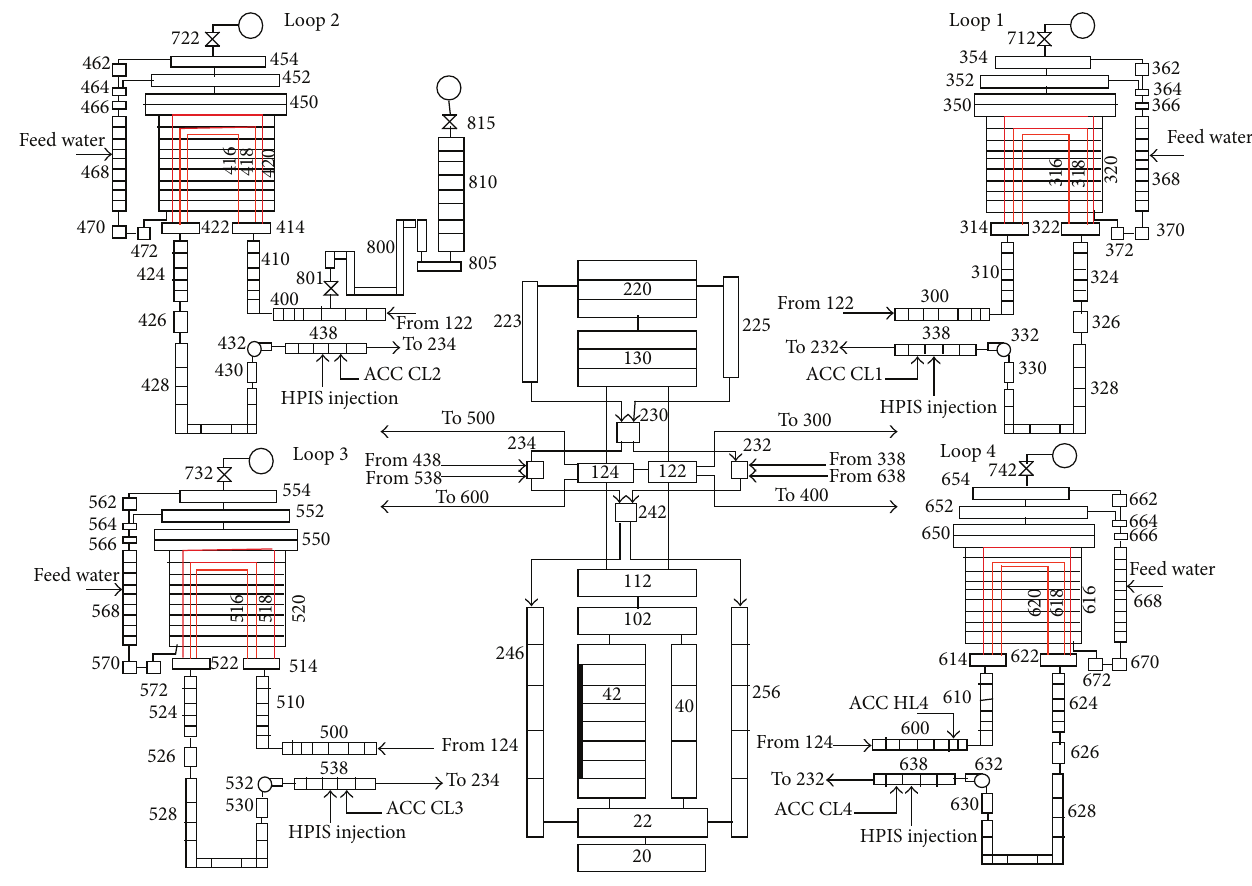
Figure 2: RELAP5 nodalization of PKL